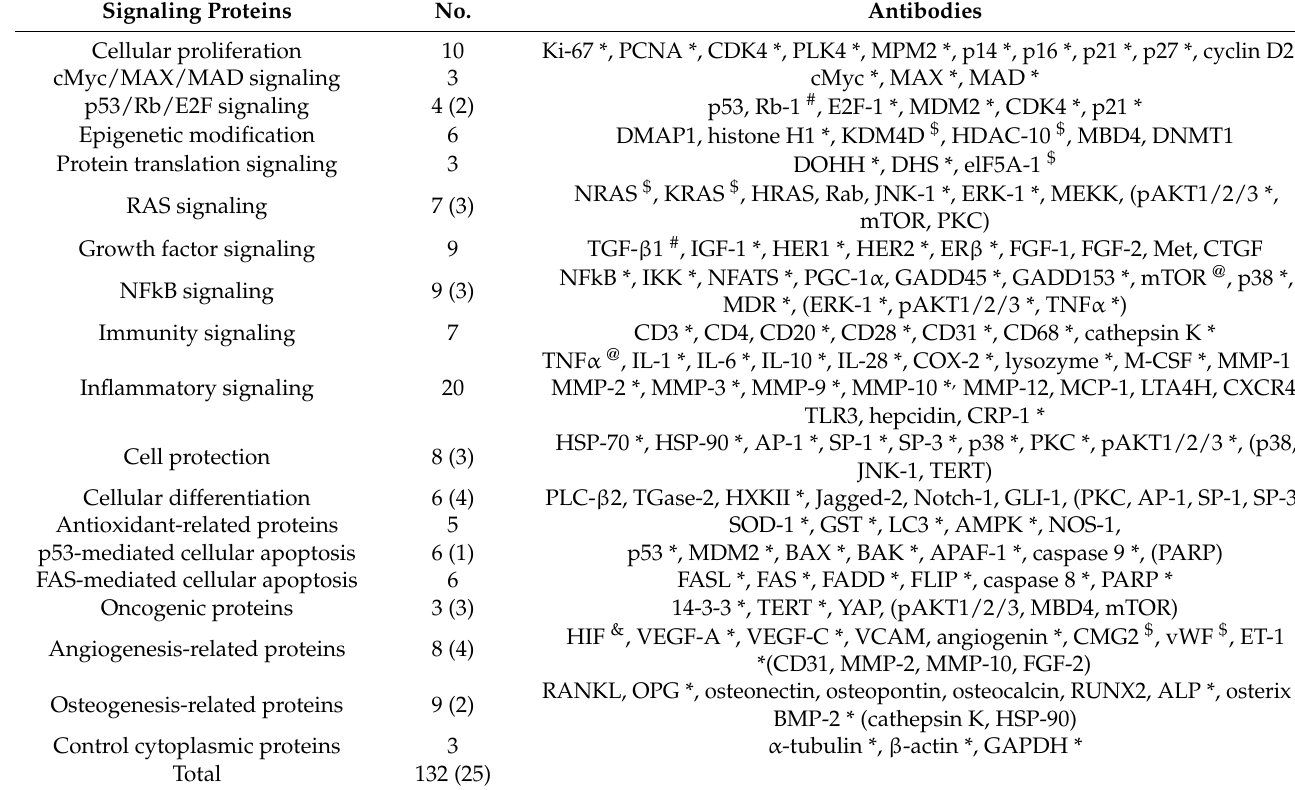
Table 1. All 132 antibodies used in this